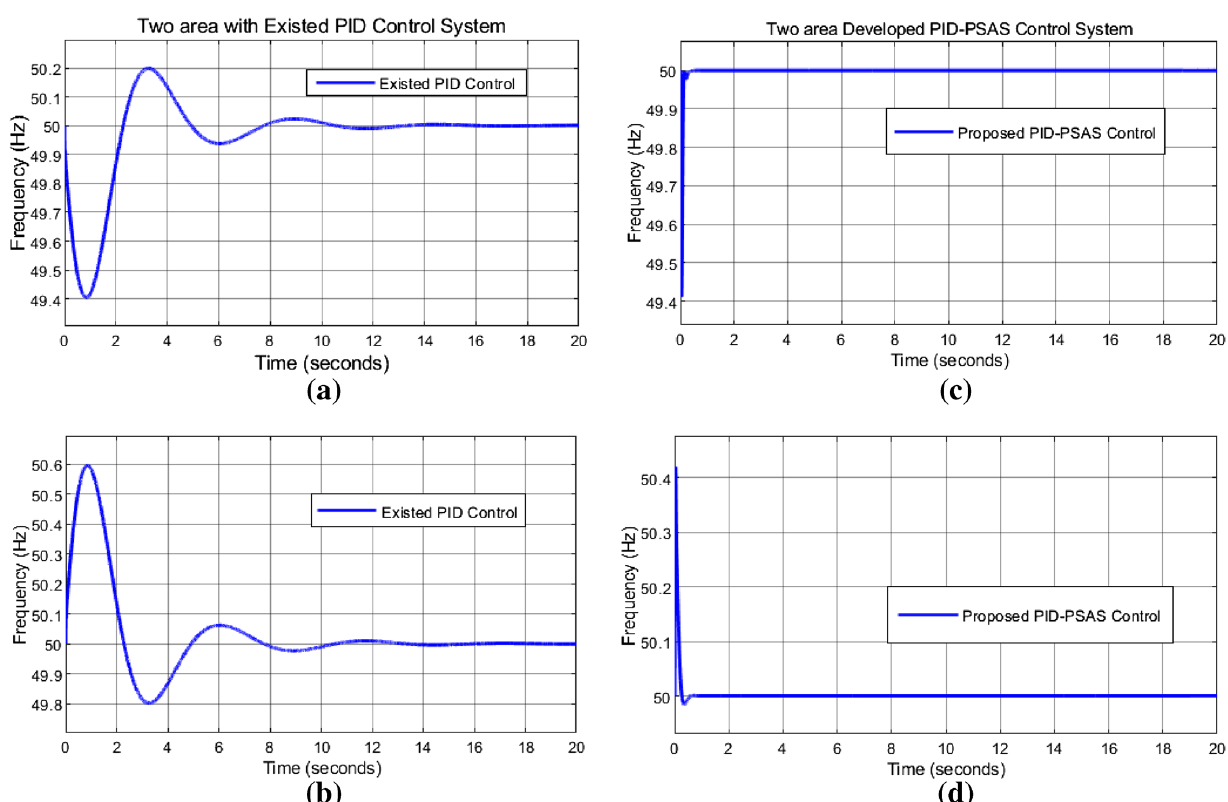
Fig. 11 Frequency responses with a existing PID control scheme Load disturbance increment b existing PID control scheme Load disturbance decrement c Proposed PID-PSAS control scheme with